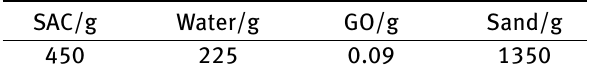
Table 2: Mix proportion of GO-SAC